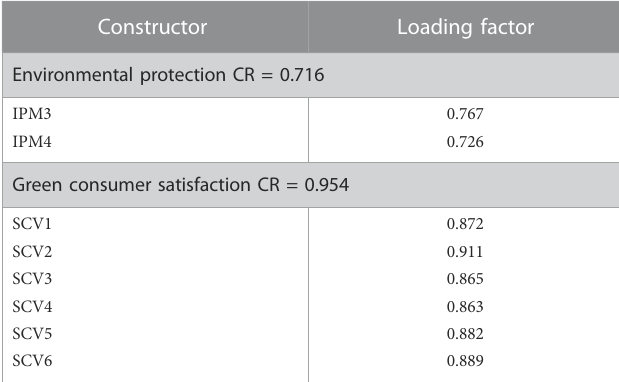
TABLE 4 Constructor